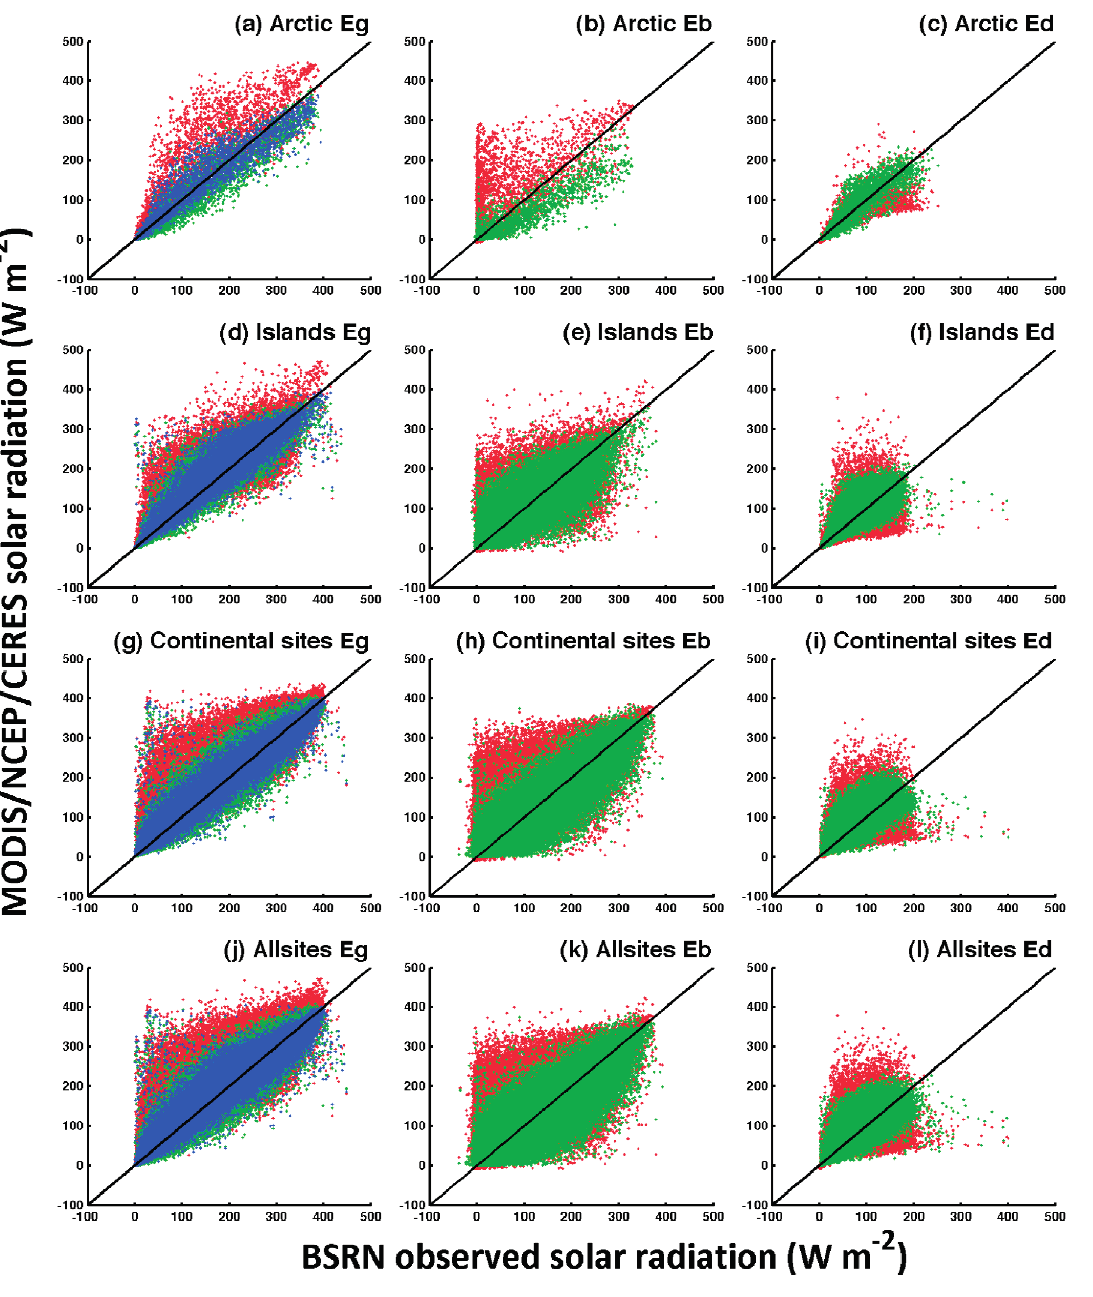
Figure 3. Scatterplots of the MODIS, NCEP and CERES daily total, direct and diffuse solar radiation with BSRN observations under all-sky conditions for different geographic regions (a–i) . x -axis is BSRN observations and y -axis is the data from MODIS, NCEP and CERES. The red, green and blue dots represent the NCEP, MODIS and CERES data,